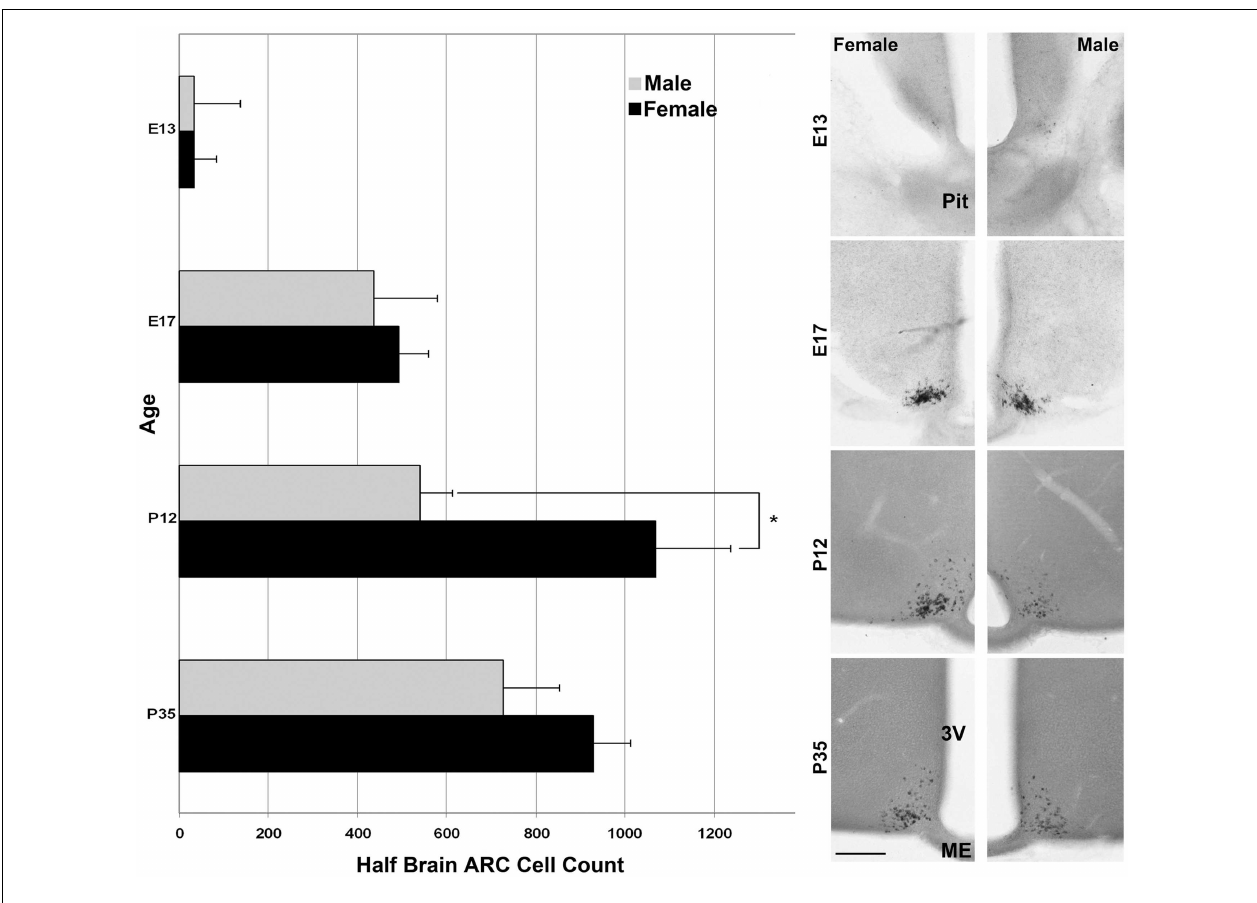
optical density of reaction product between males (images in the right column) and females (left column).This difference is most visibly evident at P12 and P35 but is notable at all ages examined at higher magnification. Pit, pituitary; 3V, third ventricle, ME, median eminence. Scale bar = 100 µ